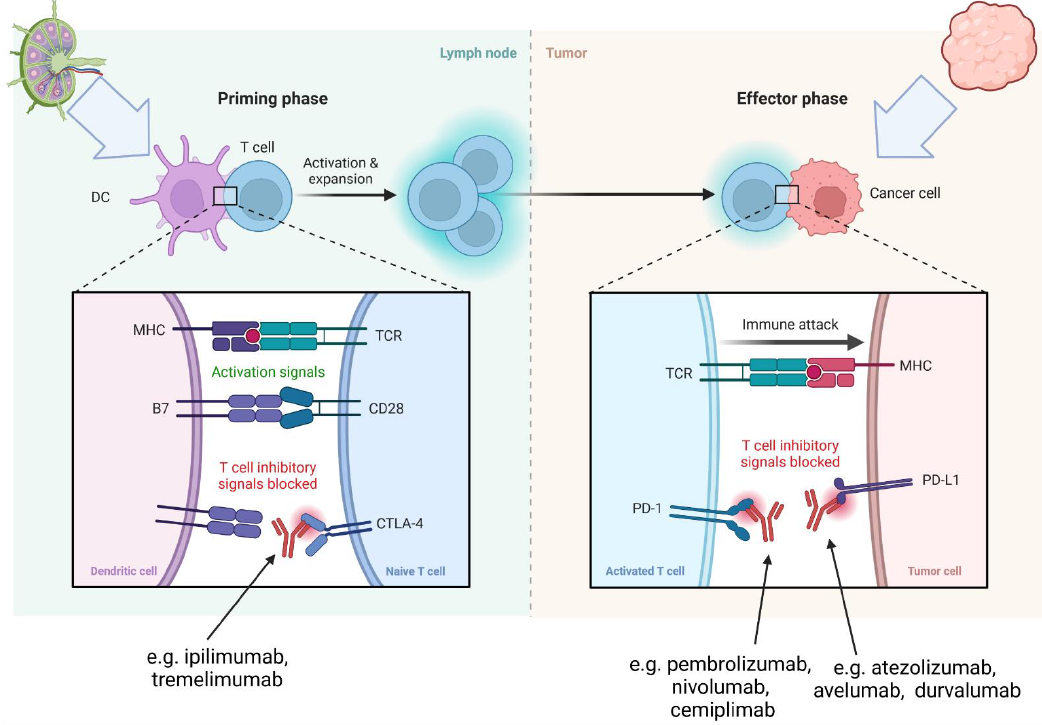
Figure 1. Mechanism of blockade of CTLA-4 or PD-1 signaling in tumor immunotherapy and exam- ples of drugs used in melanoma therapy. CTLA-cytotoxic T cell antigen, PD-programmed cell death protein, MHC-major histocompatibility complex, TCR-T-cell receptor, CD-cluster of differentiation DC-dendritic cell Cardiotoxicity is an infrequent irAE during melanoma treatment. Among cardiac- related irAEs left ventricular dysfunction, heart failure, myocarditis, myocardial fibrosis, takotsubo syndrome, QT prolongation, arrhythmias, heart block, cardiac arrest, acute cor-